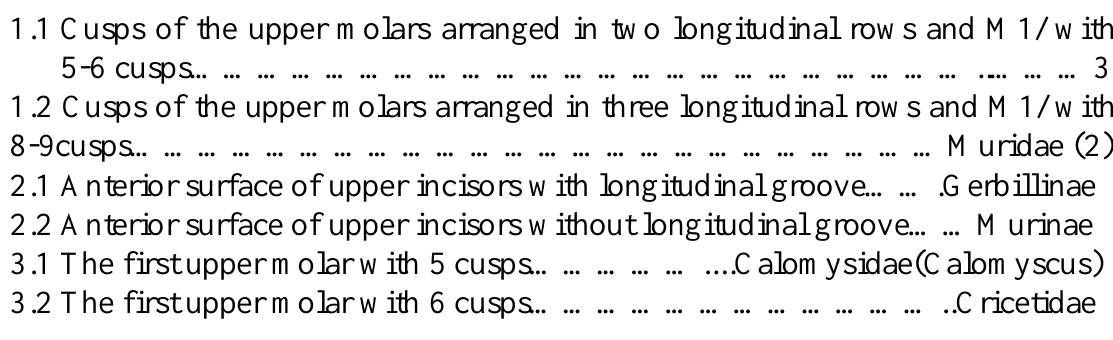
Key to recognize Muroidae